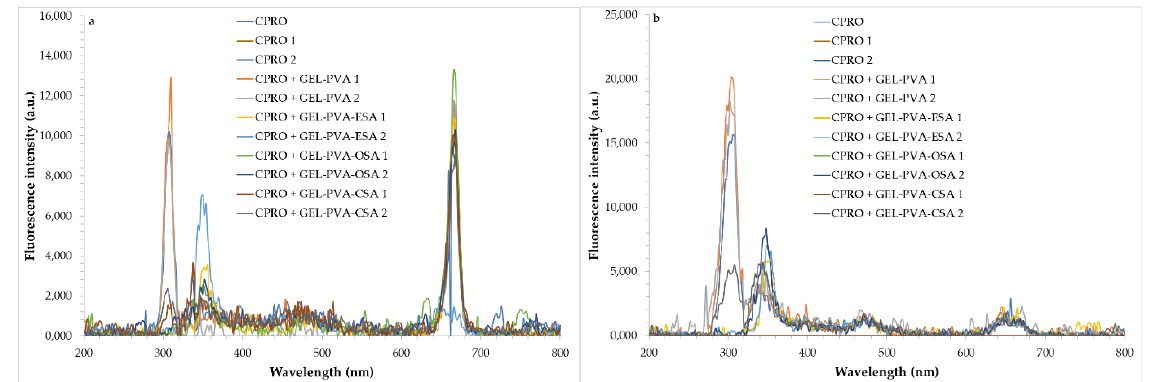
Figure 3. Synchronous fluorescence spectra of cold-pressed rapeseed oil (CPRO) samples packaged in dark glass bottles without and with film strips diluted in n-hexane (c = 10%) and recorded at Δλ = 10 nm ( a ) and Δλ = 30 nm ( b ) after storage at accelerated conditions.